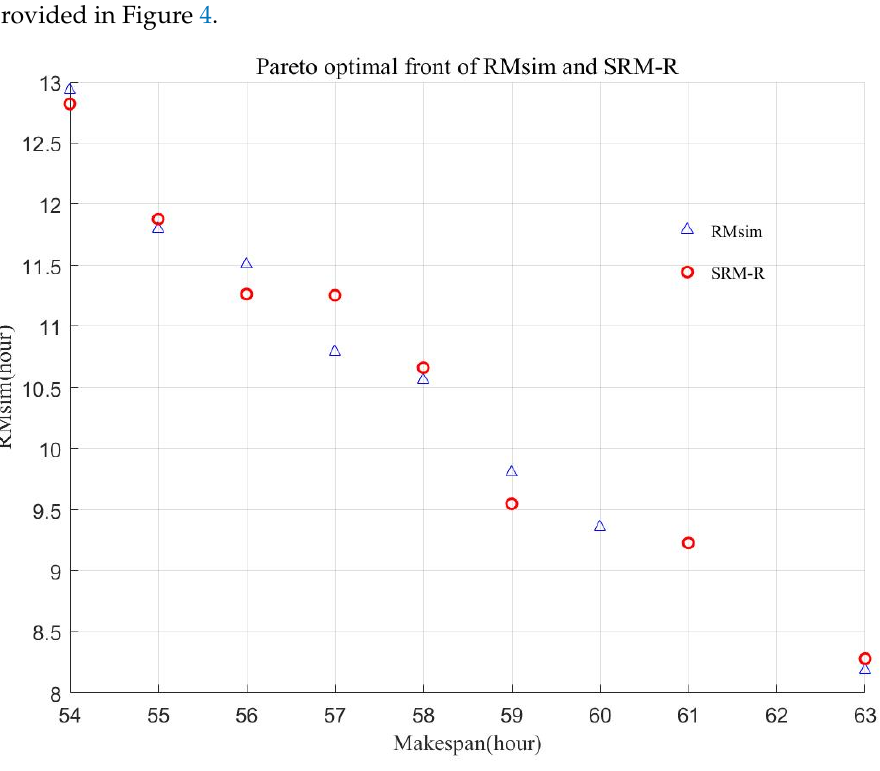
Figure 4. The Pareto optimal front of the comparison robustness measures. The variation range of RMsim is 8.18–12.93; (12.93–8.18)/12.93 = 31.9%. The